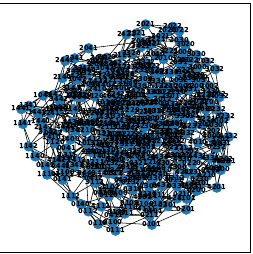
Figure 7. Largest connected component in BC 5,2